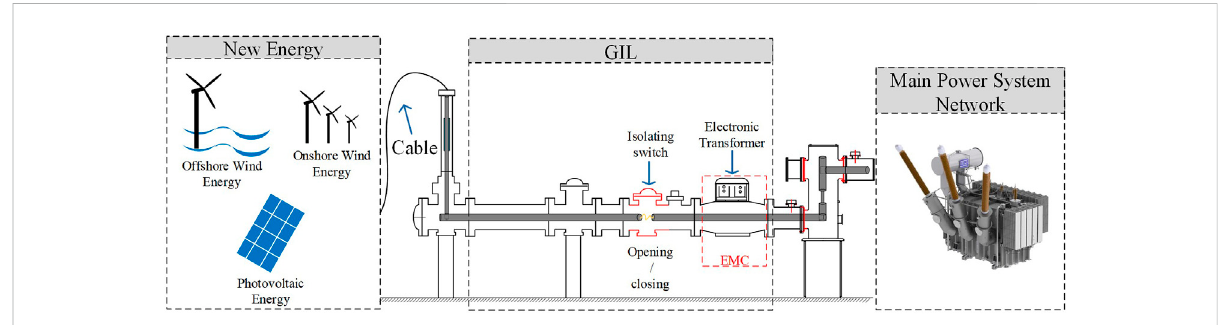
FIGURE 1 Schematic diagram of the grid connection process of the new energy